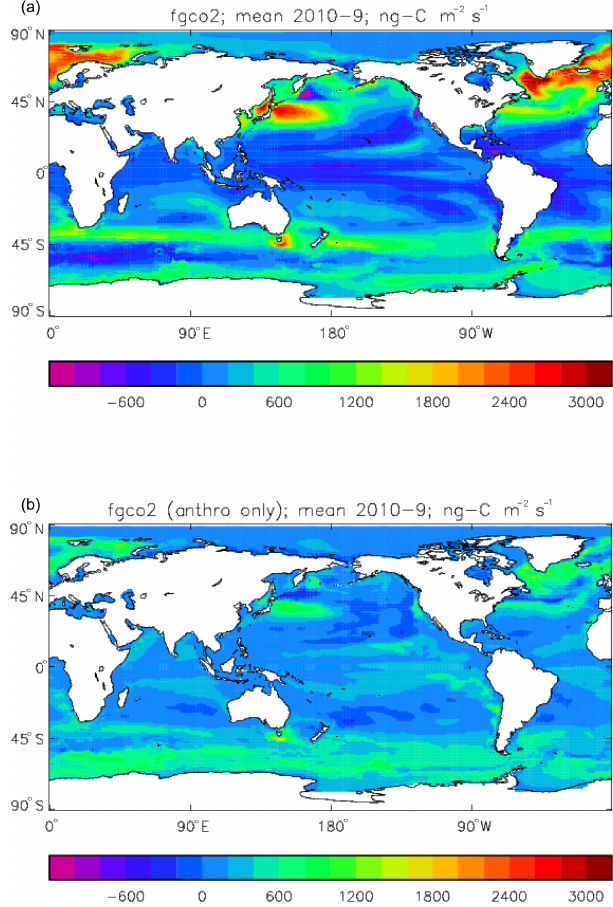
Figure 19. Total air-to-sea flux of CO 2 (ngCm − 2 s − 1 ; positive values into the ocean), mean over model years 2010–2019: (a) to- tal flux (natural cycle and anthropogenic perturbation); (b) anthro- pogenic